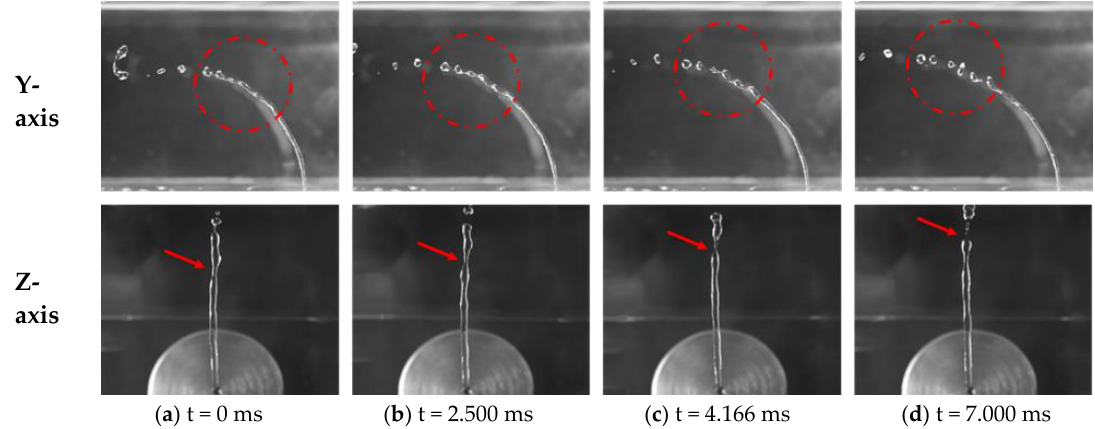
Figure 5. Bump breakup mechanism for We g = 1.43 We j = 162.11 d j = 1 mm.